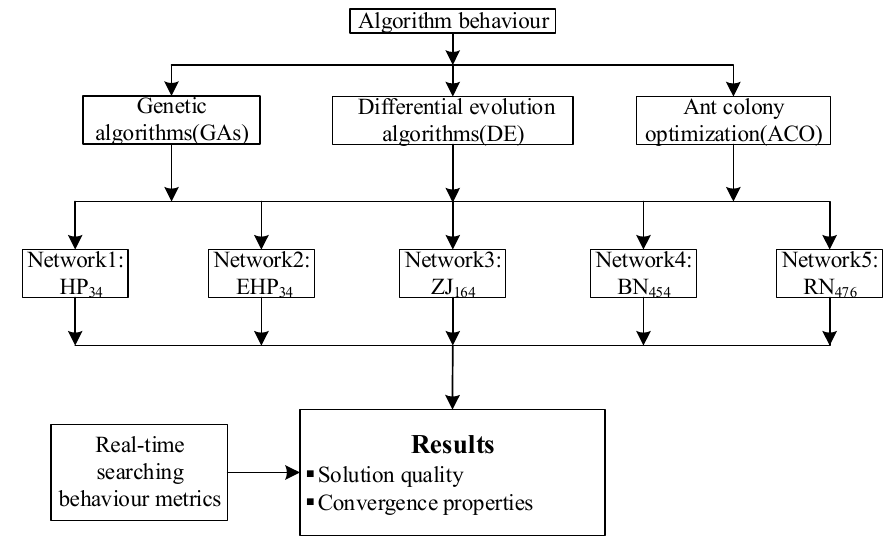
Figure 1. The overall methodology of the proposed method.